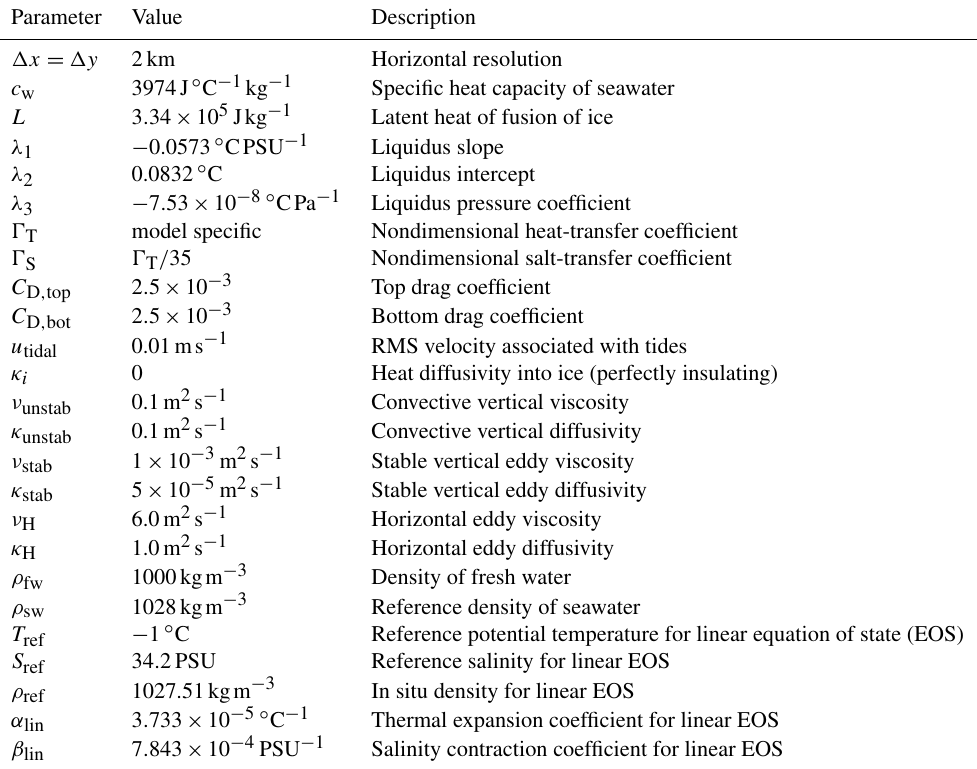
Table 4. Parameters recommended for the common (COM) experiments. Parameter Value Description (cid:49)x = (cid:49)y 2km Horizontal